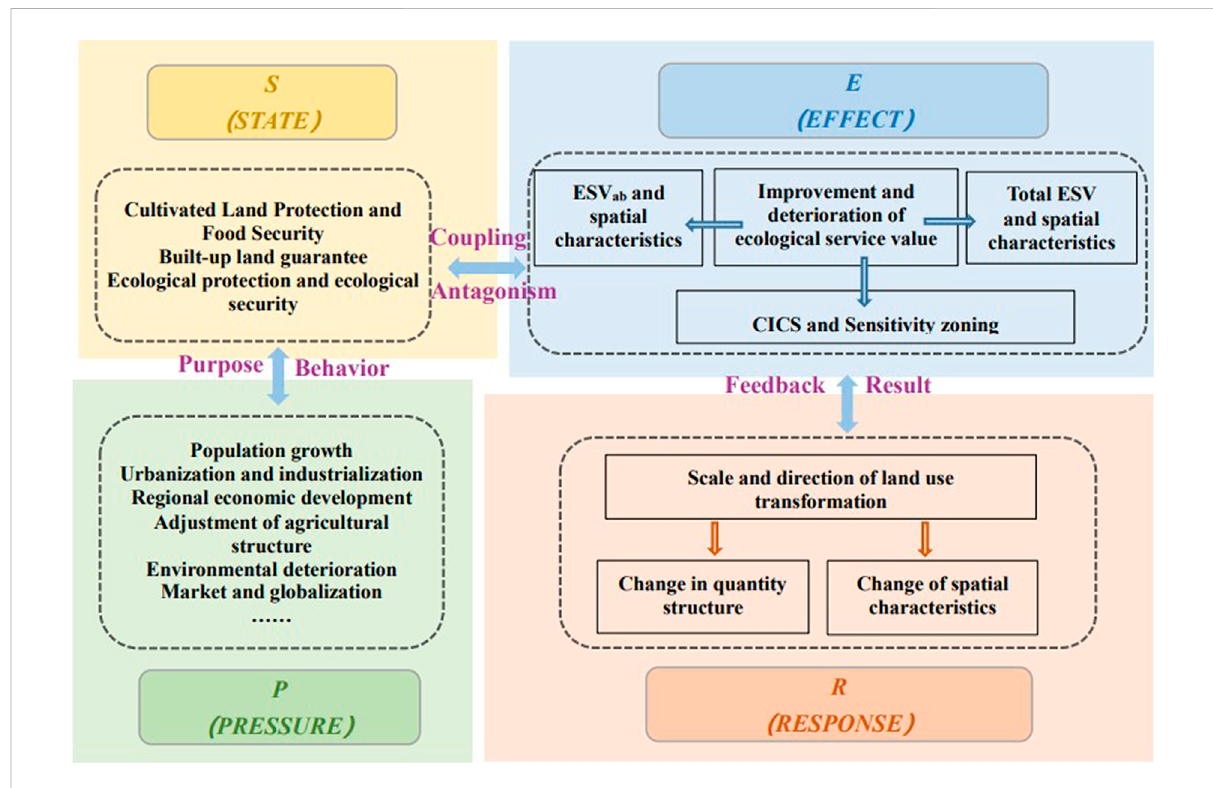
FIGURE 1 Framework diagram of land use transition mechanism based on “ Pressure-State-Effect-Response ” model.